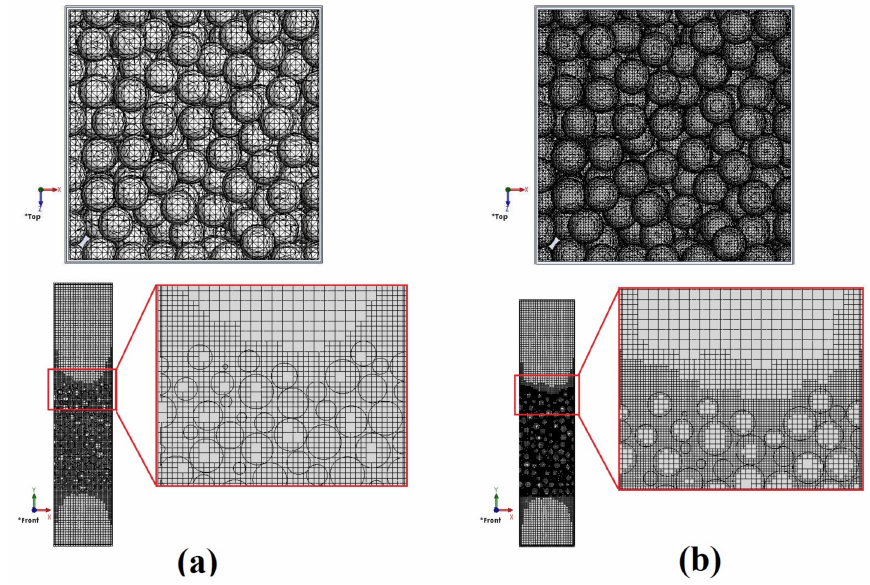
Figure 10. Random model meshes for ( a ) initial mesh level 7; ( b ) initial mesh level 7 with 1 refinement